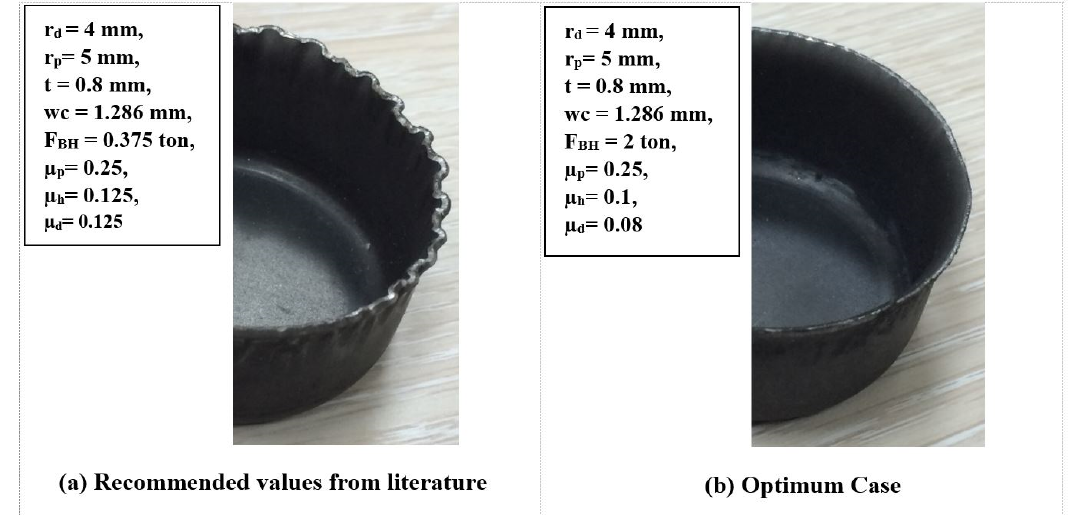
Figure 15. Comparison of the experimental wrinkling formations: ( a ) recommended values from the literature; ( b ) optimum case.